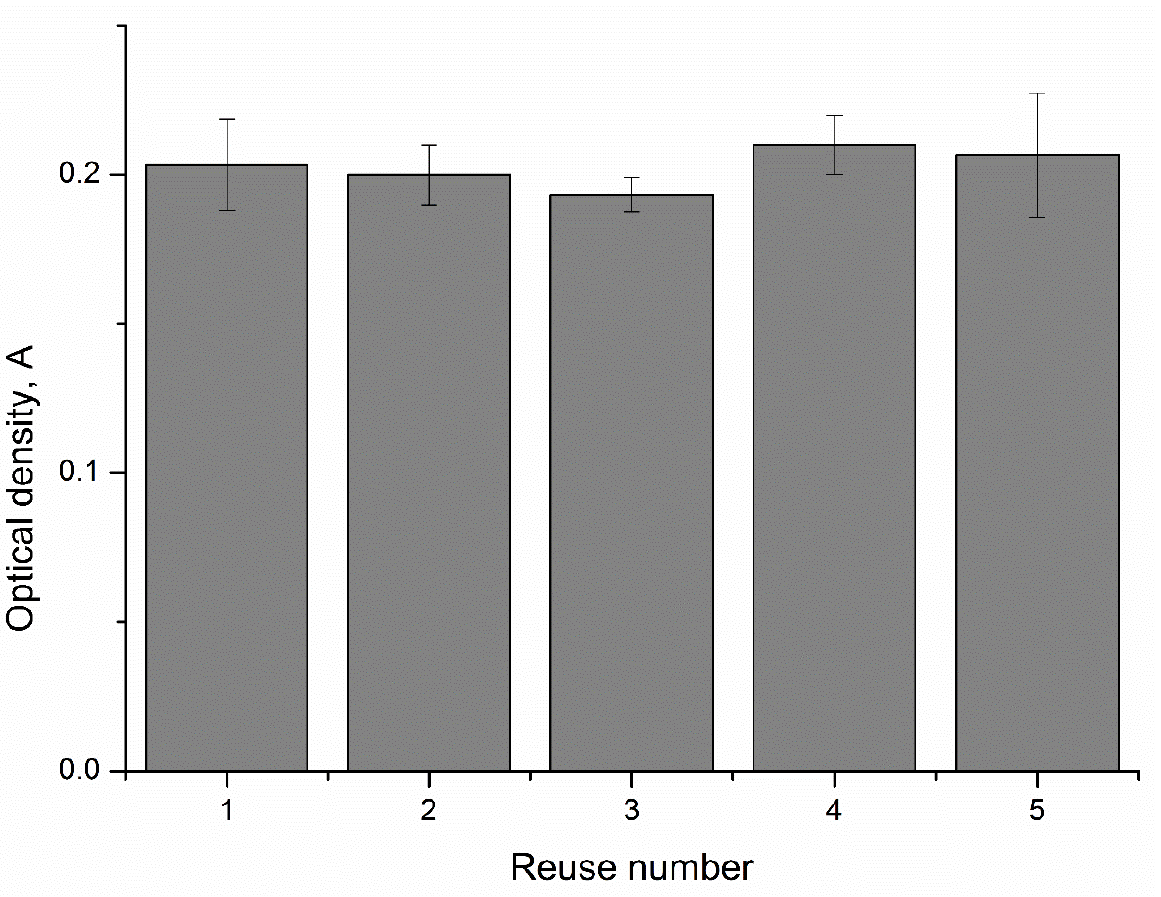
Figure 6. The reuse ability of CaCO 3 –peroxidase microparticles for the determination of phenol con- centration.